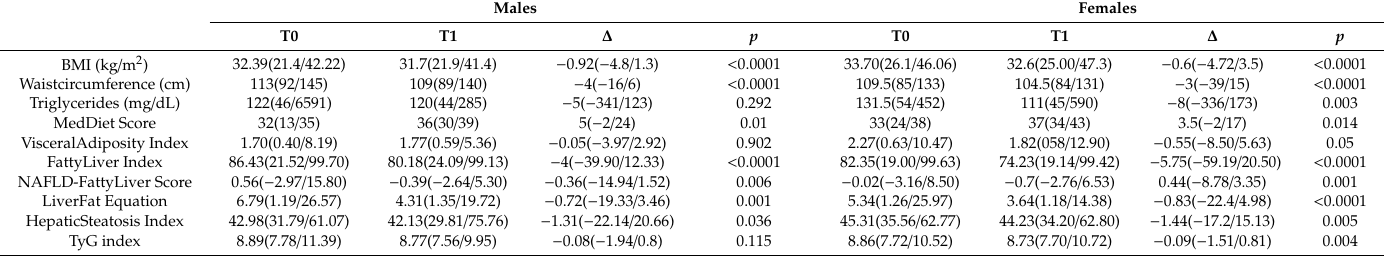
Table 3. Anthropometric, nutritional data and hepatic steatosis indices at baseline (T0) and after three months (T1) of intensive lifestyle program. Data are expressed as median (min /